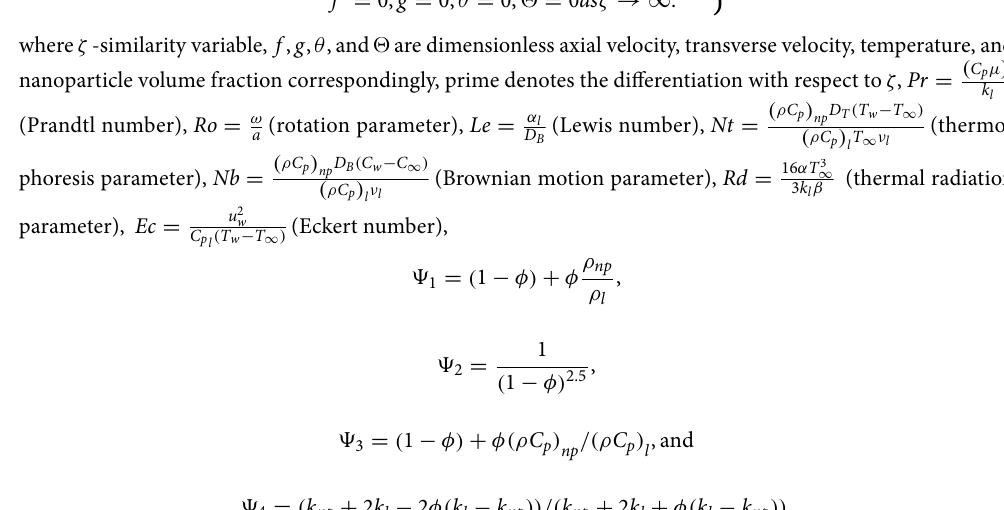
α l Le D B (Lewis number), = (Brownian motion parameter), Rd